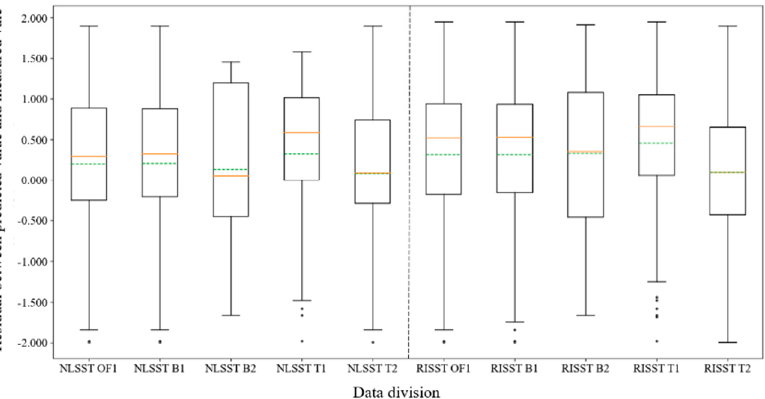
Figure 5. Residual boxplot of the eNLSST and RISST algorithms with group OF1, B1, B2, T1, and T2.